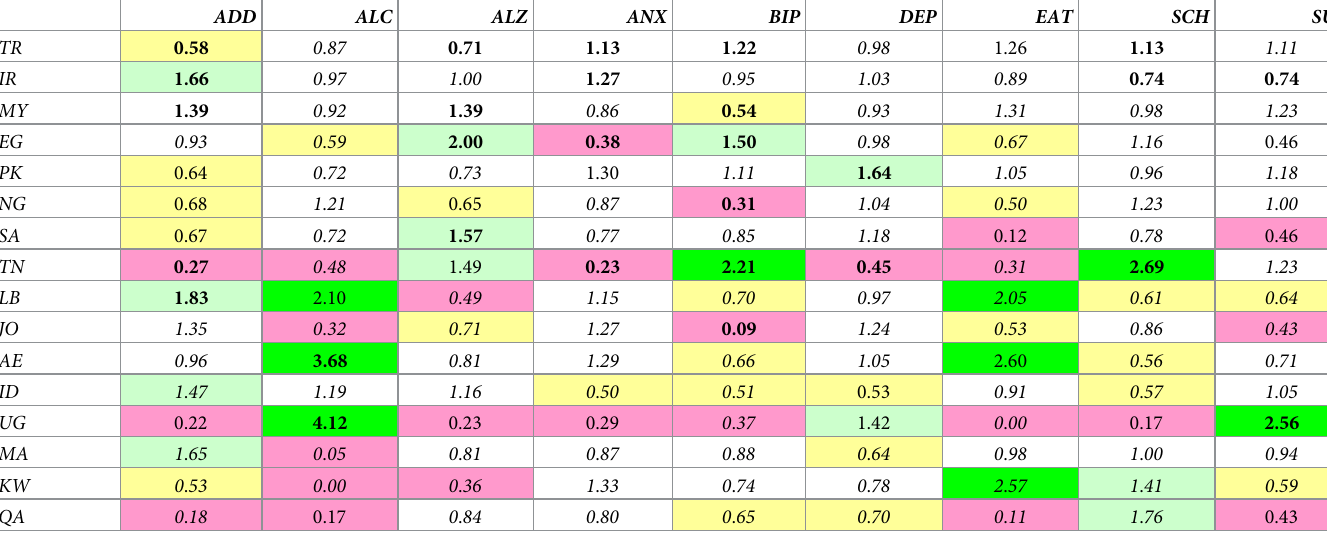
Table 6. The relative commitment to research on each of nine mental health disorders by the 16 leading OIC countries, fractional counts.